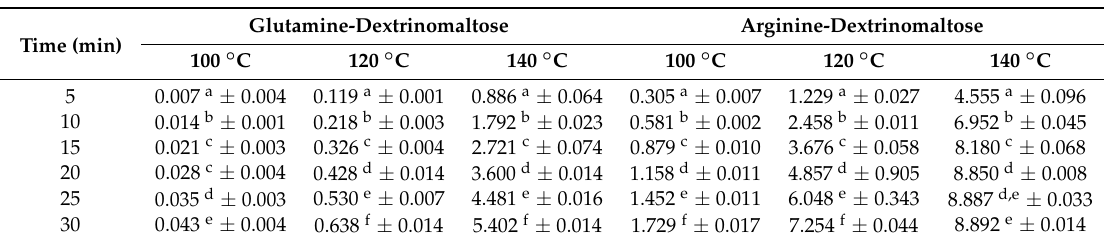
Table 5. Absorbance at 420 nm. Values are means ± SD, n = 3; Different letters within a column indicate significant differences between groups ( p <